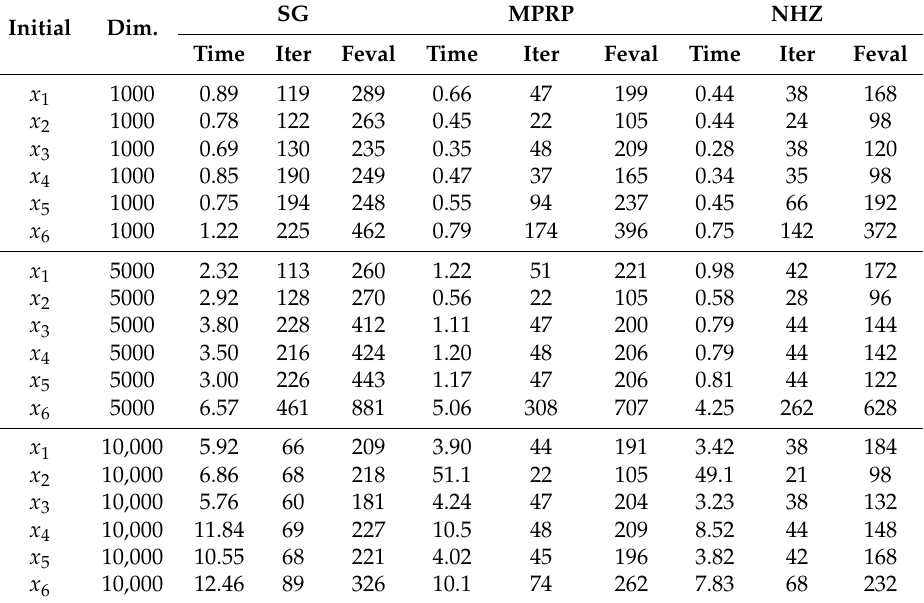
Table 5. Numerical results for the tested Problem 5 with various sizes and given initial points.